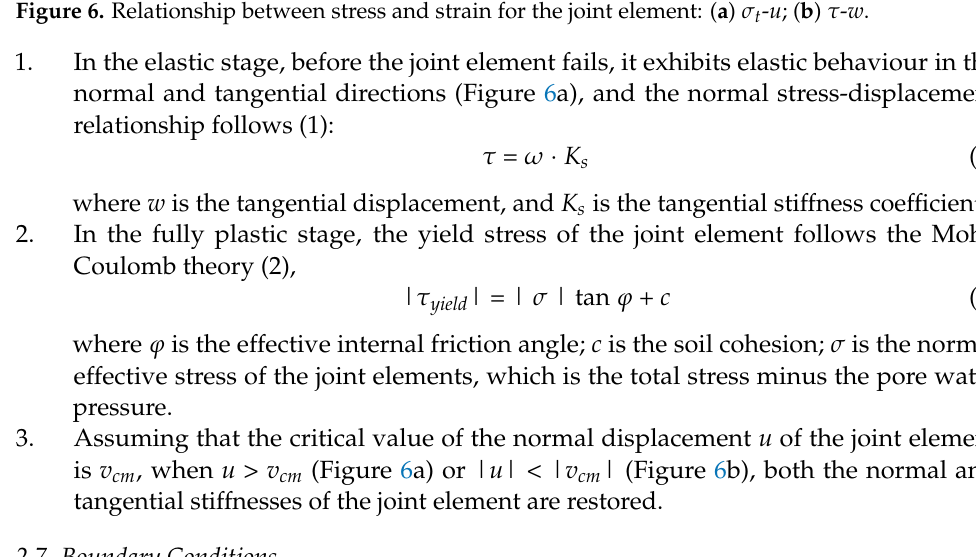
Figure 6. Relationship between stress and strain for the joint element: ( a ) σ t - u ; ( b ) τ - w .